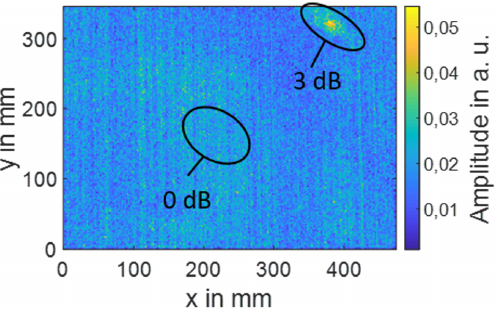
Figure 11. Testing result of a CFRP plate with two impact damages with 0 and 3dB SNR,